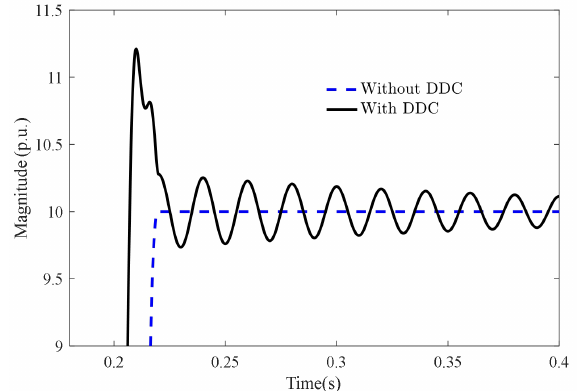
Figure 5. Amplitude of a typical FC signal with/without